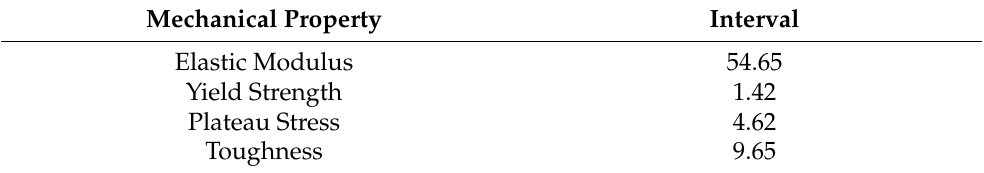
Table 13. 95% confidence intervals based on reduced interaction